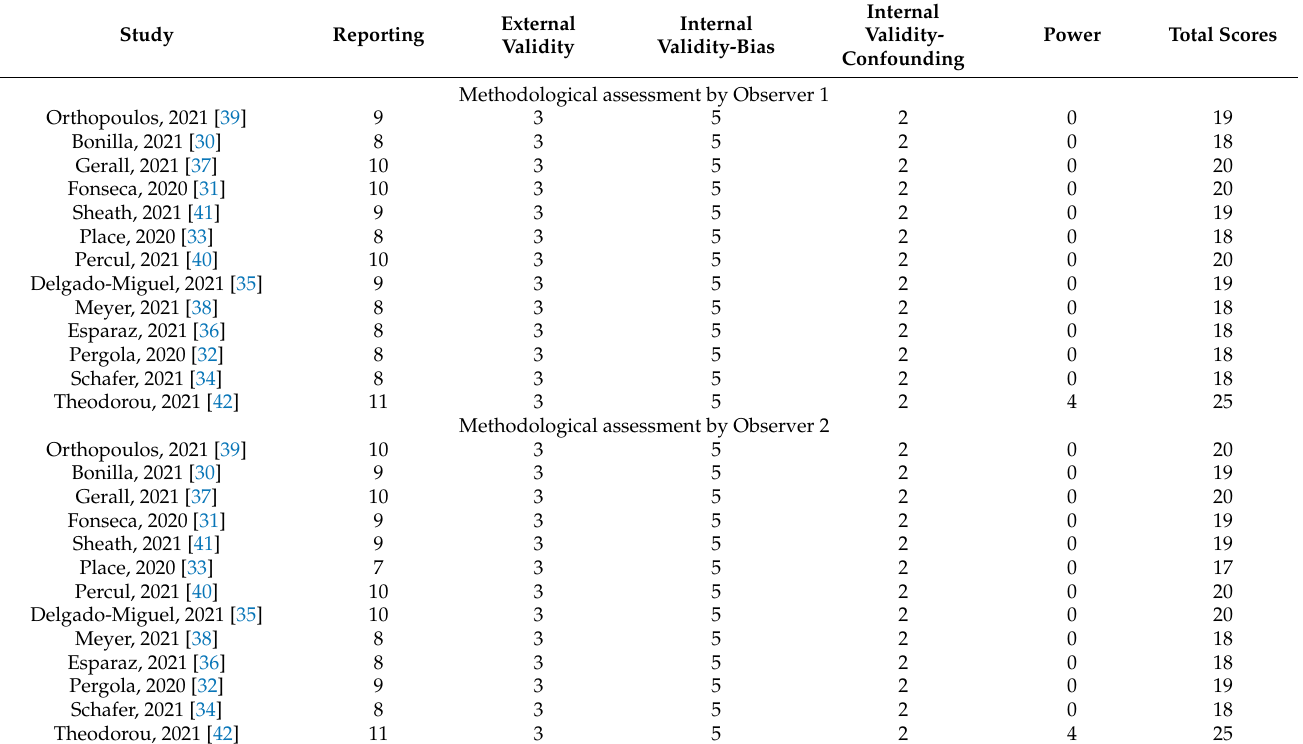
Table 2. Downs and Black scale scores for the included studies by Observer 1 and Observer